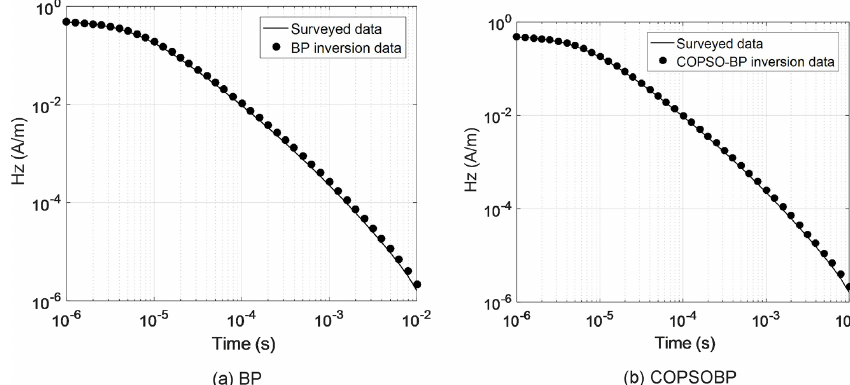
Figure 13. 1-D inversion of forward results for (a) BP and (b) COPSO-BP.